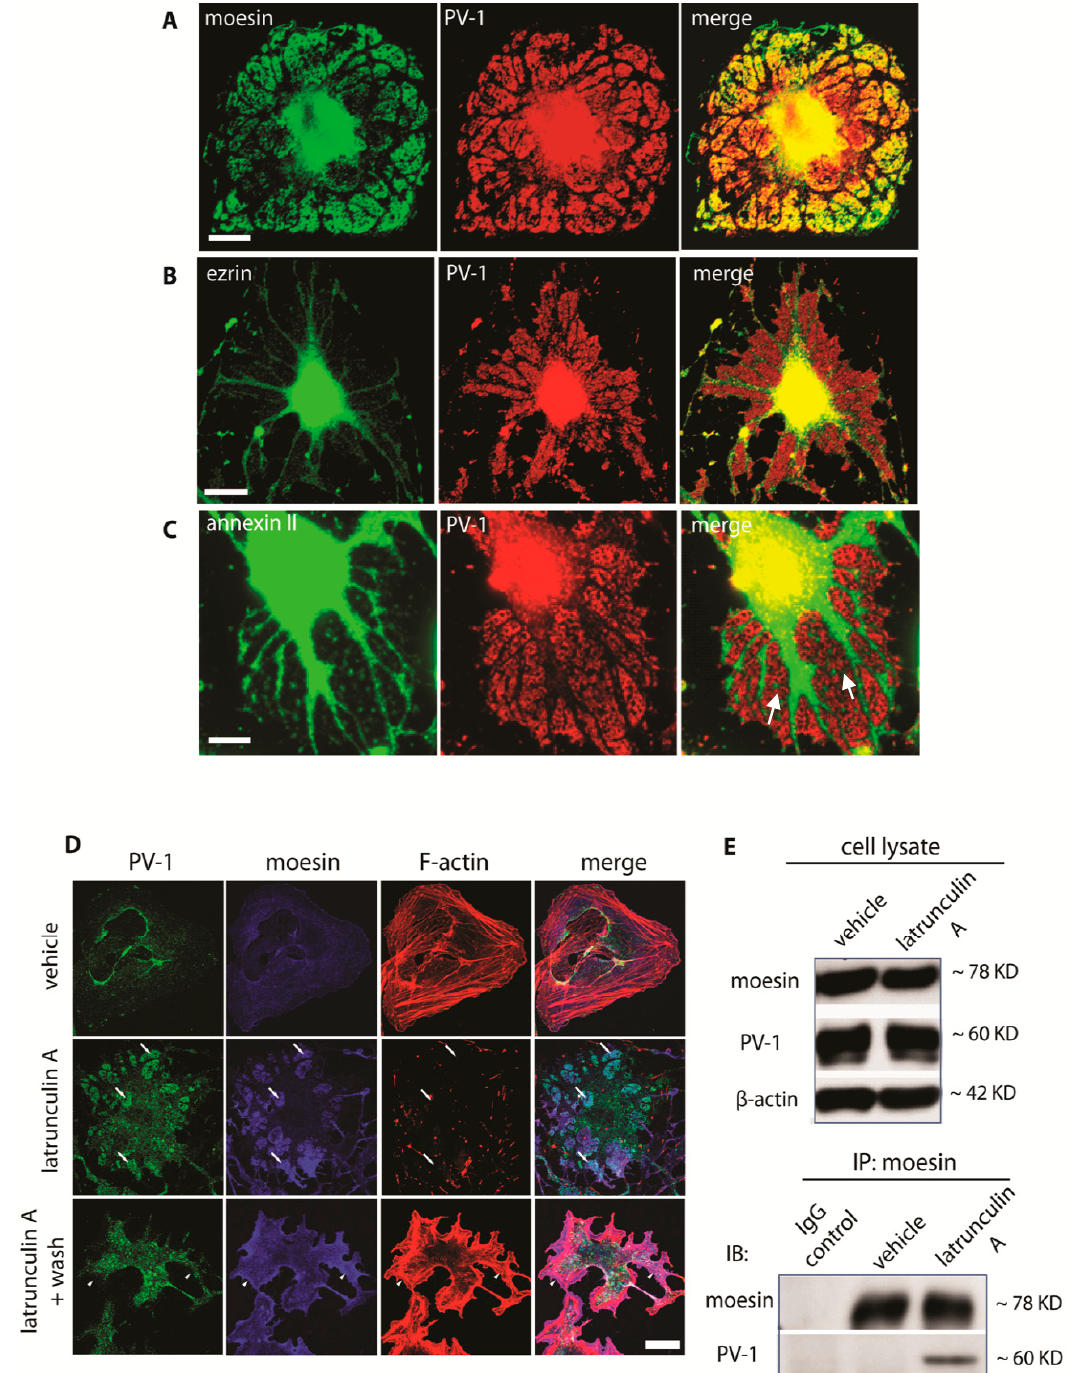
Figure 2. Moesin and annexin II are in fenestral sieve plates (see also Figure S1). ( A ) Moesin was detected in the LtA-induced sieve plates, and it colocalised with PV-1. Arrows, fenestral sieve plates; scale bar, 10 µ m. ( B ) The ERM family member ezrin was excluded from the sieve plates. Scale bar, 10 µ m. ( C ) Annexin II did not colocalise with PV-1 but was localised to small islands within the sieve plates (arrows); scale bar, 10 µ m. ( D ) Upon disassembly of actin microfilaments following exposure to LtA, both moesin and PV-1 were redistributed into the distinct sieve plates (arrows). Following LtA washout, fenestrae rapidly disappeared and PV-1, moesin, and F-actin were redistributed to distinct areas of the cell periphery (arrow heads). Scale bar, 10 µ m. ( E ) Immunoprecipitation with a moesin antibody demonstrated that moesin and PV-1 are only in a protein complex following fenestra induction.